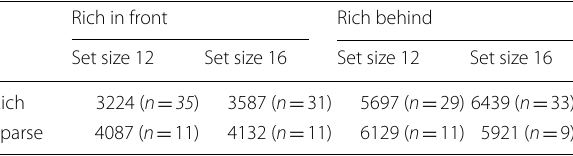
This table includes data from the training phase of the experiment. The number of observations differs across conditions. The average number of observations under each condition is indicated parenthetically and labeled as